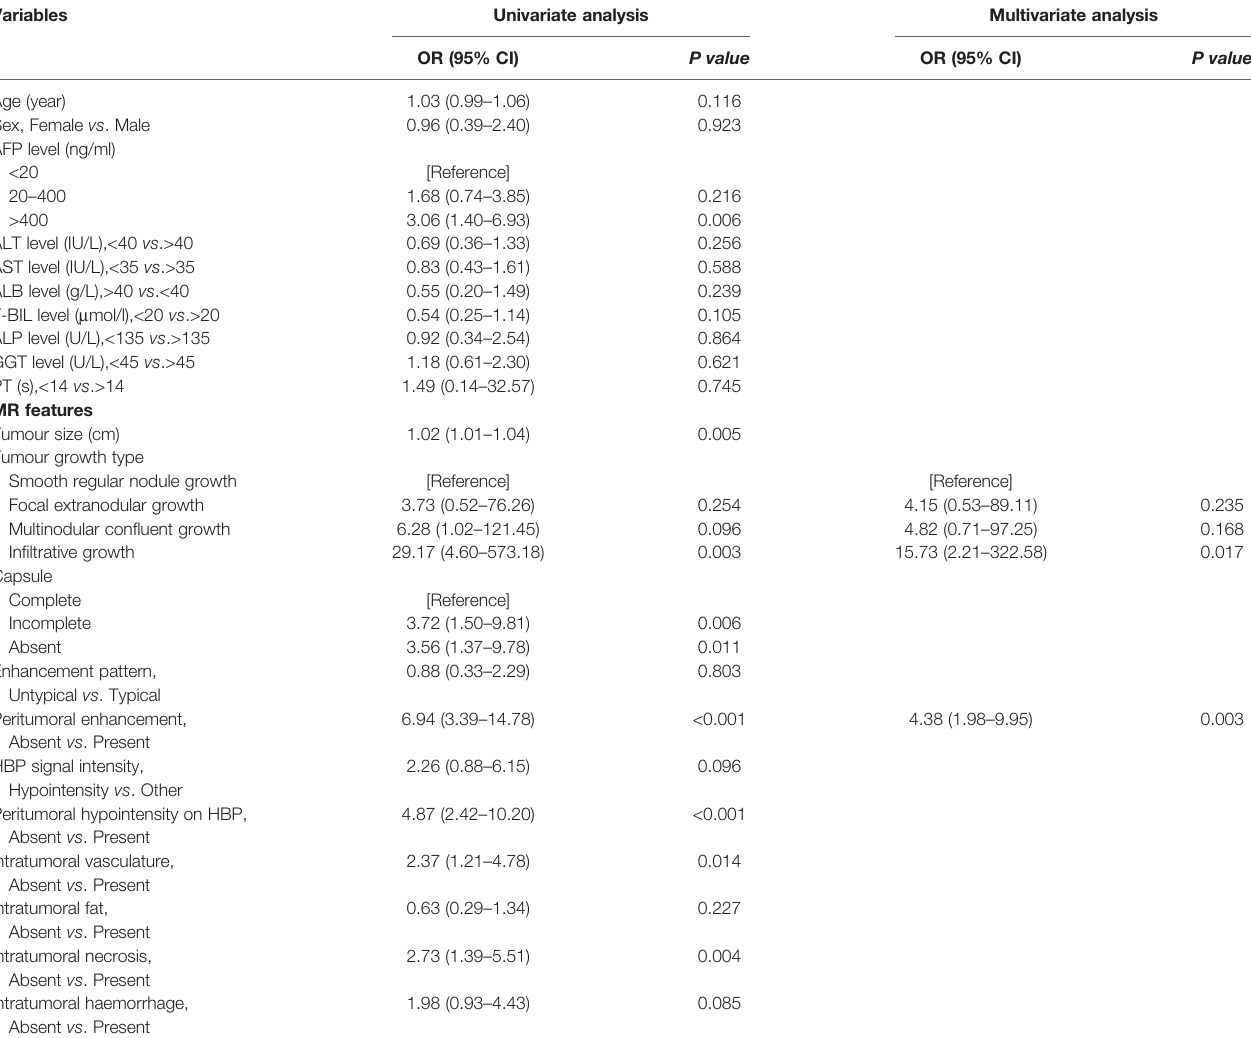
TABLE 2 | Logistic regression analysis showing the association of variables with MVI presence in the training